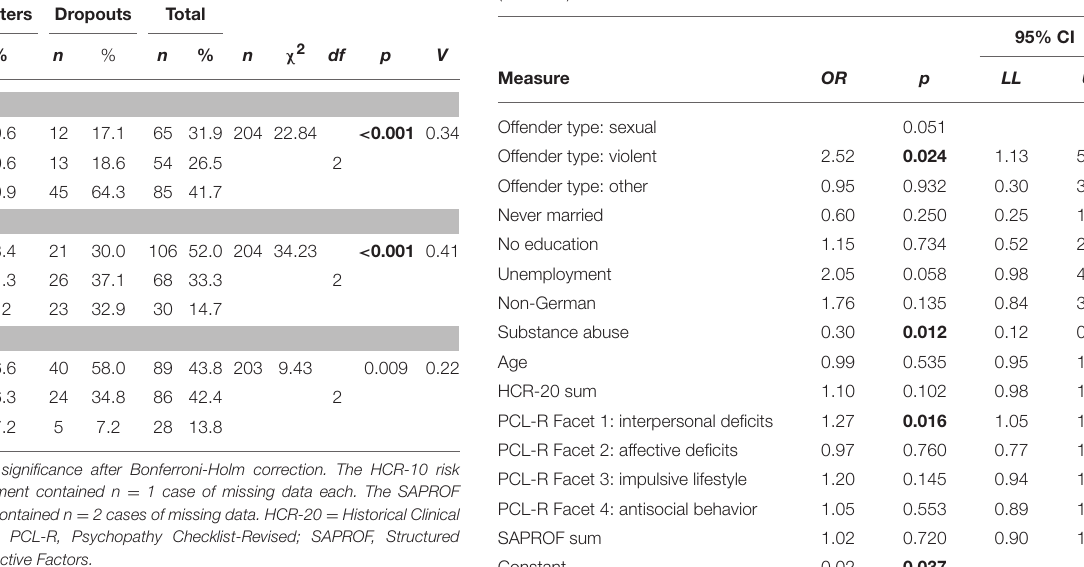
TABLE 5 | Logistic regression analysis predicting treatment dropout–first model ( N =